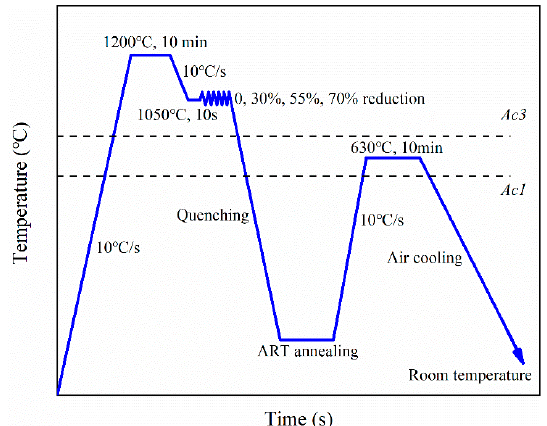
Figure 2. Thermal cycles of the austenite reverted transformation (ART) annealing processes performed in a Gleeble-3800 thermal simulator with different deformation degrees.